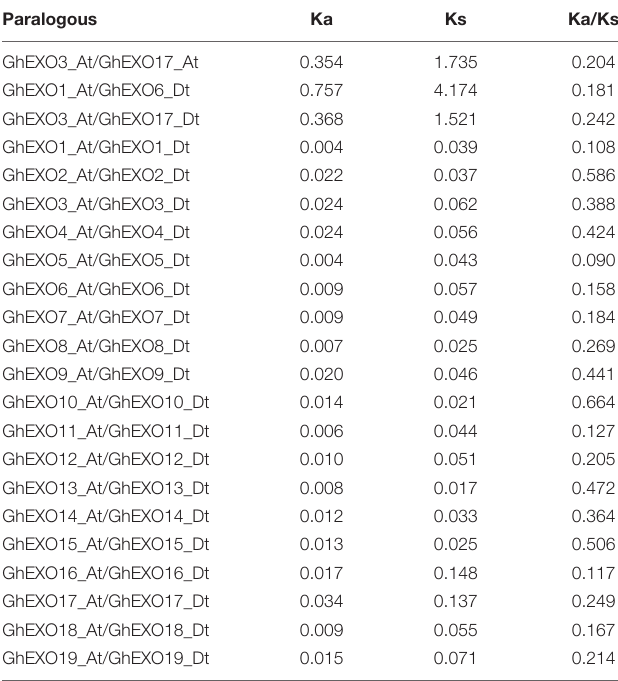
TABLE 2 | The Ka and Ks values for homologous gene pairs in cotton.